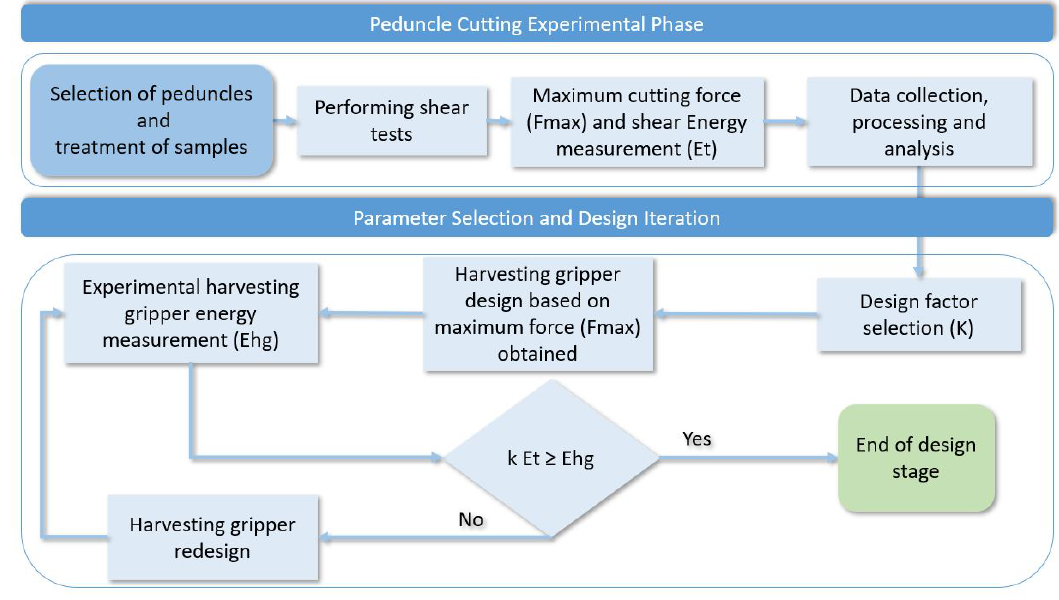
Figure 14. Procedure for parameter